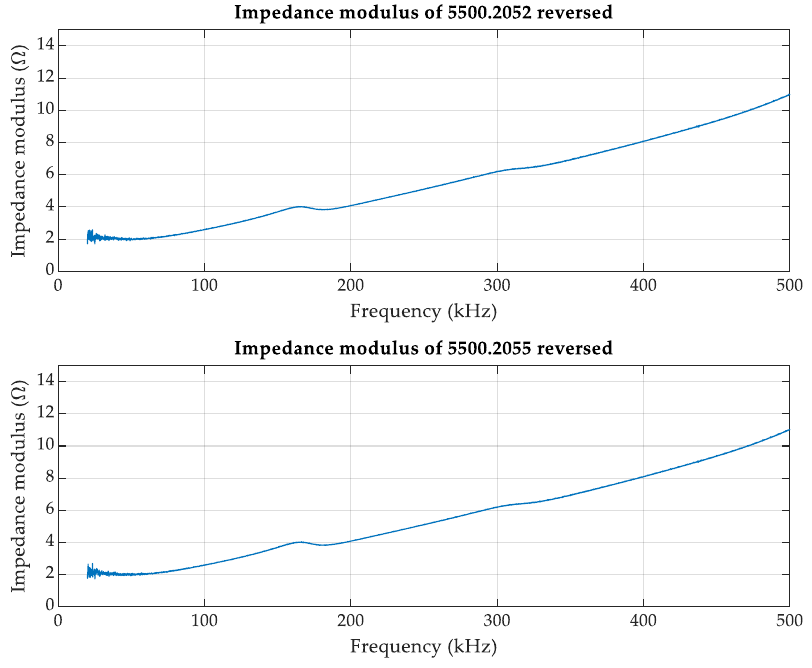
Figure 10. Impedance modulus of the filters 5500.2052 and 5500.2055 reversed. The results lead to conclude that, if the filters are connected reversed, the impedance measured corresponds to the impedance of the LISN without significant influence by the filter, as observed when comparing Figures 3 and 10. Hence, in this situation, the PLC signal should not be attenuated by the introduction of the EMC filter. In order to analyze the attenuation in this case, each graph in Figure 11 shows the attenuation when the filters are connected to the setup through ports L-N (blue lines) and L’-N’ (red lines). The column indicates the filter under study: the first column corresponds to 5500.2052 and the second column to 5500.2055. The row indicates the location of the EMC filter: A, B and C. Figure 11 clearly shows how, regardless of their location, the attenuation introduced by the filters when connected to the setup through the L’-N’ ports can be considered negligible. Thus, it is demonstrated that the attenuation introduced by the EMC filters is mainly due to the capacitive burden they present in the network